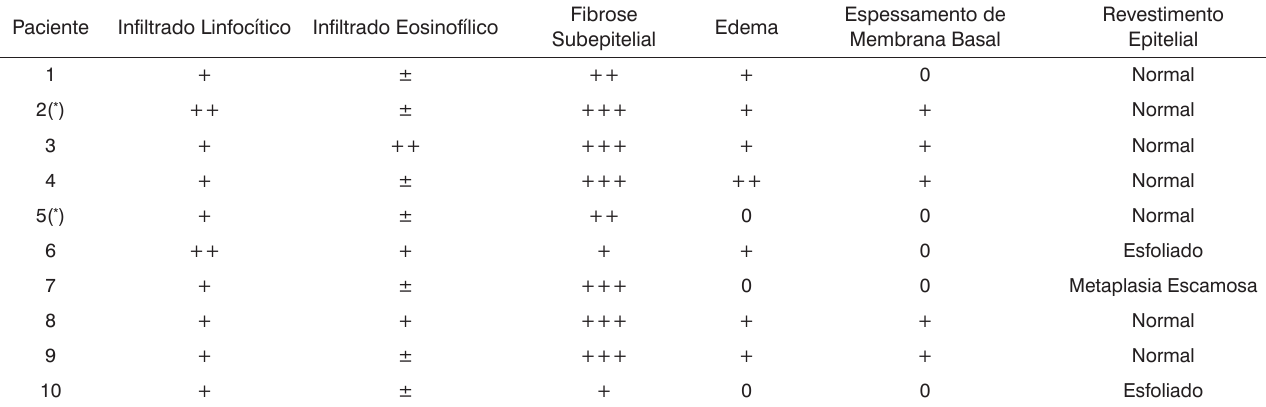
Tabela 1. Análise semi-quantitativa dos achados histopatológicos da mucosa nasal de portadores do HTLV-1 com rinite alérgica e rinite não alérgica( *